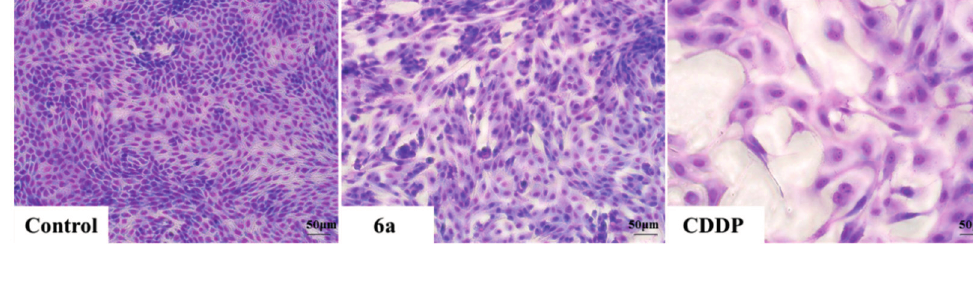
Figure 3. Morphology of MDCK cells after treatment with 6a and CDDP was observed under a microscope in the same multiples (200×). Data were derived from three independent experiments.